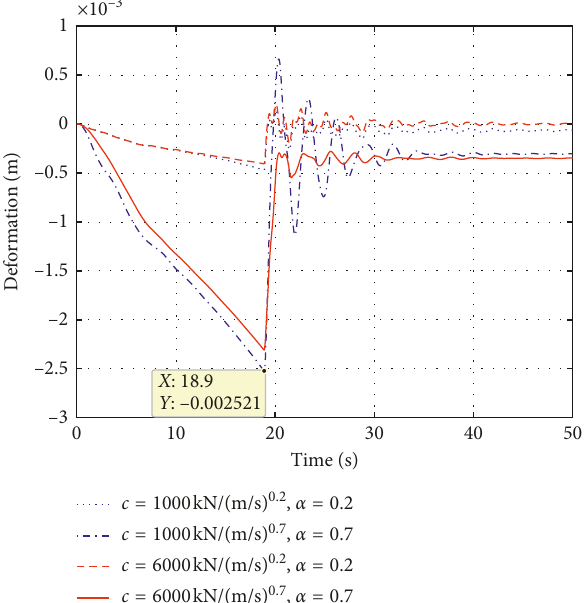
Figure 17: Longitudinal deformation of the movable